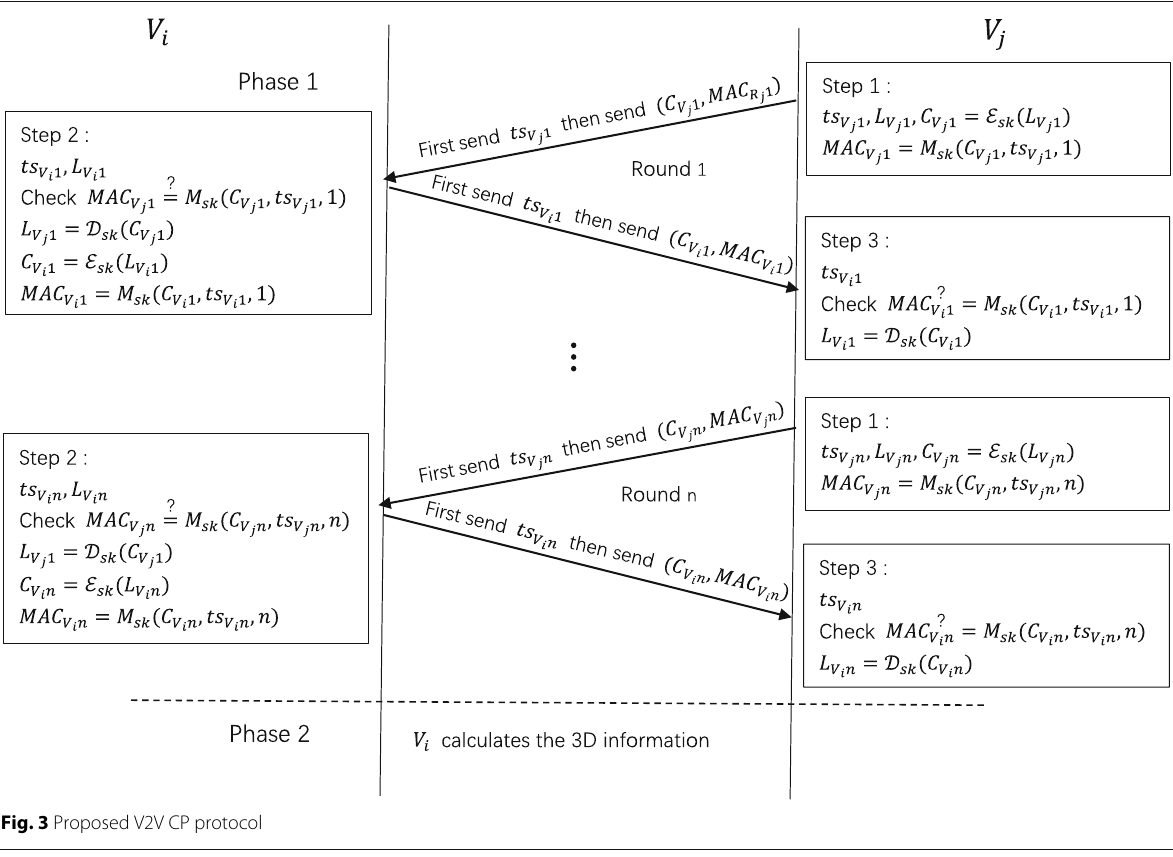
Fig. 3 Proposed V2V CP protocol